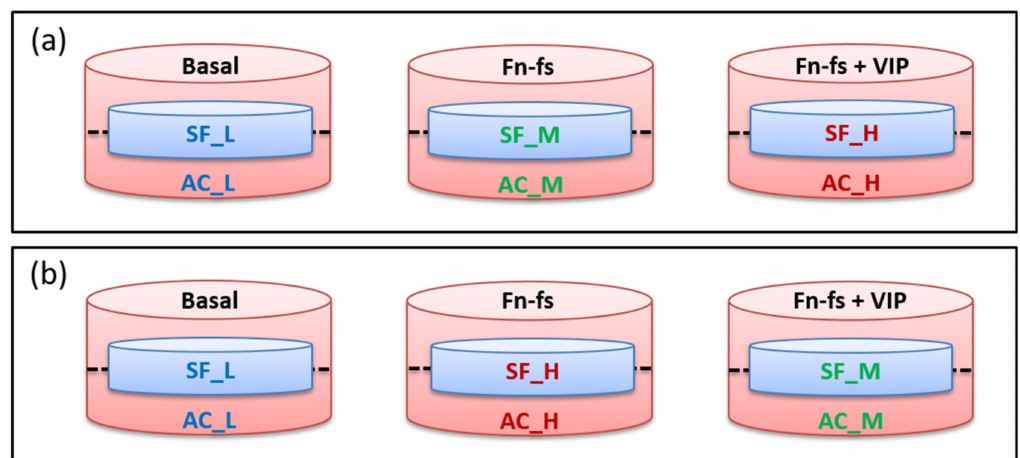
Figure 6. Experimental design of SF-AC co-cultures for SILAC analysis. ( a ) Forward replicate (Fn-fs medium/Fn-fs+VIP heavy). ( b ) Reverse replicate (Fn-fs heavy/Fn-fs+VIP medium). SF, synovial fibroblasts; AC, articular chondrocytes; L, light; M, medium; H, heavy; Fn-fs, fibronectin fragments; VIP, vasoactive intestinal peptide.